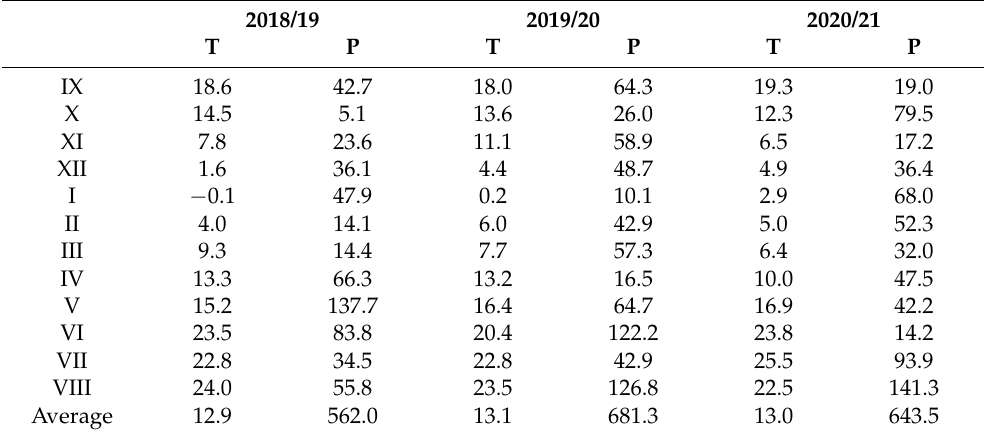
Table 2. Average monthly temperatures and precipitations for three investigated years (2018/19, 2019/20,